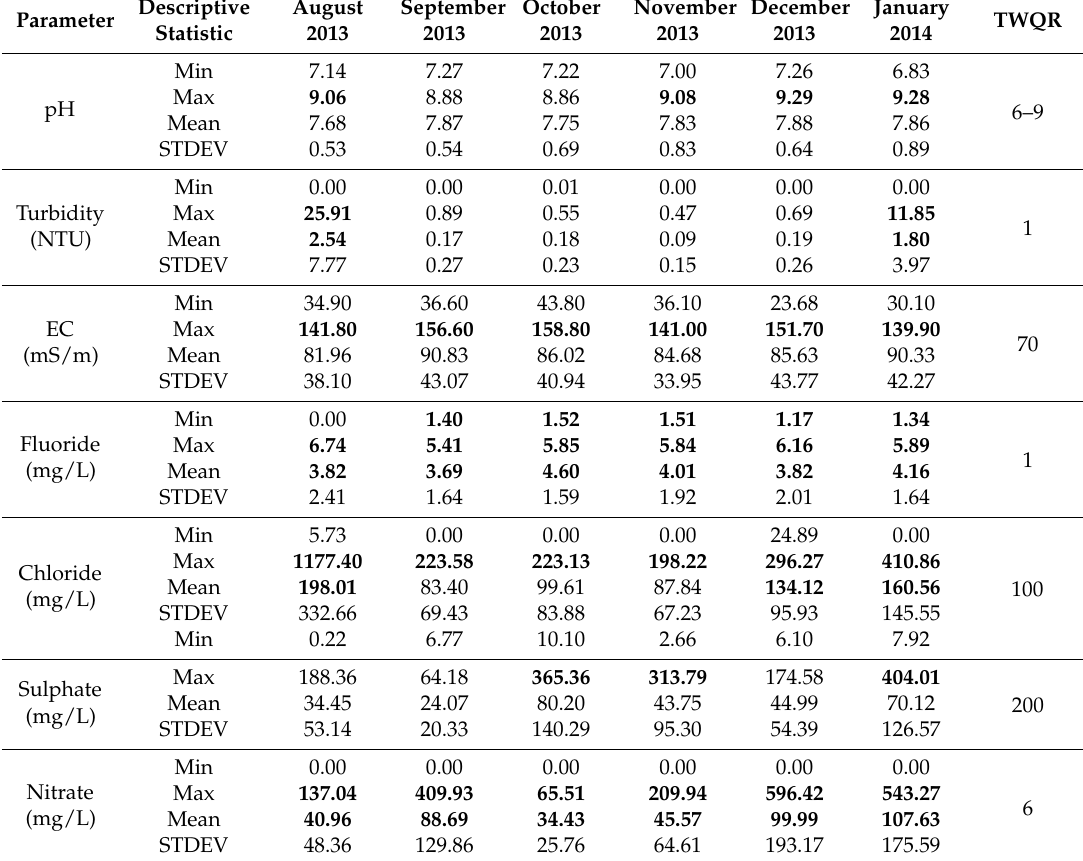
Table 1. Descriptive statistics for physical water quality parameters and